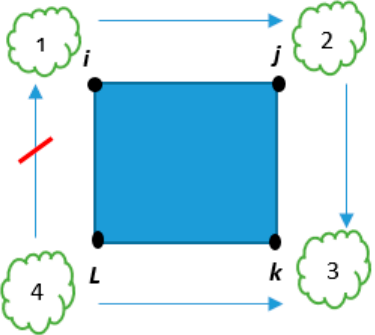
Figure 2. The Miller–Tucker–Zemlin (MTZ) number labeling that does not allow to construct arc i , l